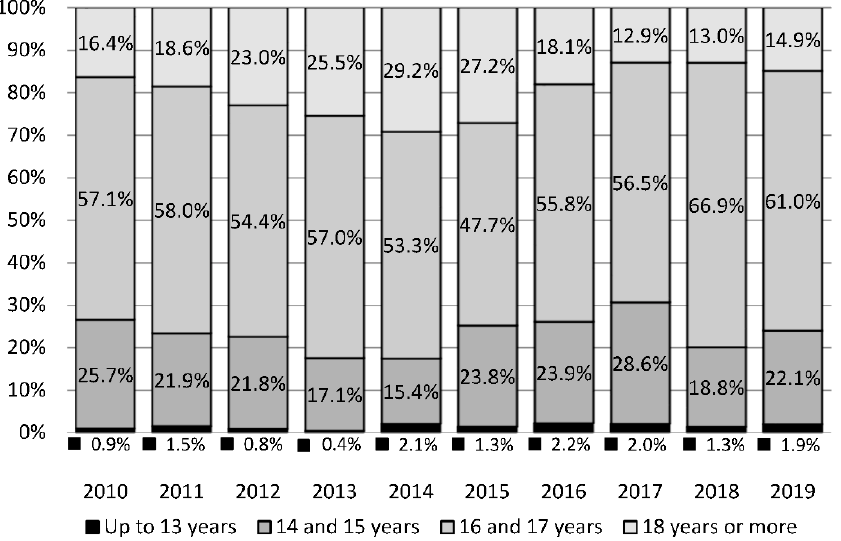
Figure 4. Juveniles detained in educational centers by age (2010–2019). Source: own elaboration, based in DGPJ 2020.